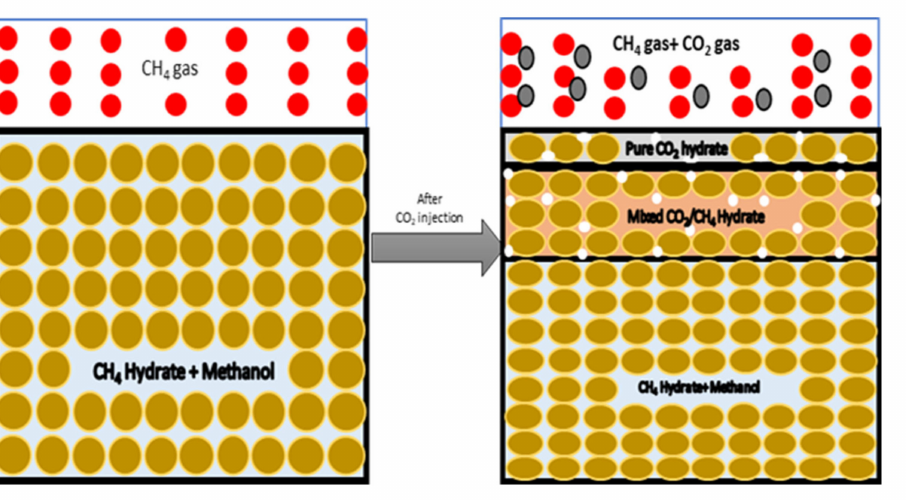
Figure 4. Schematic of gas injection into methane hydrate-containing sediments and subsequent CO 2